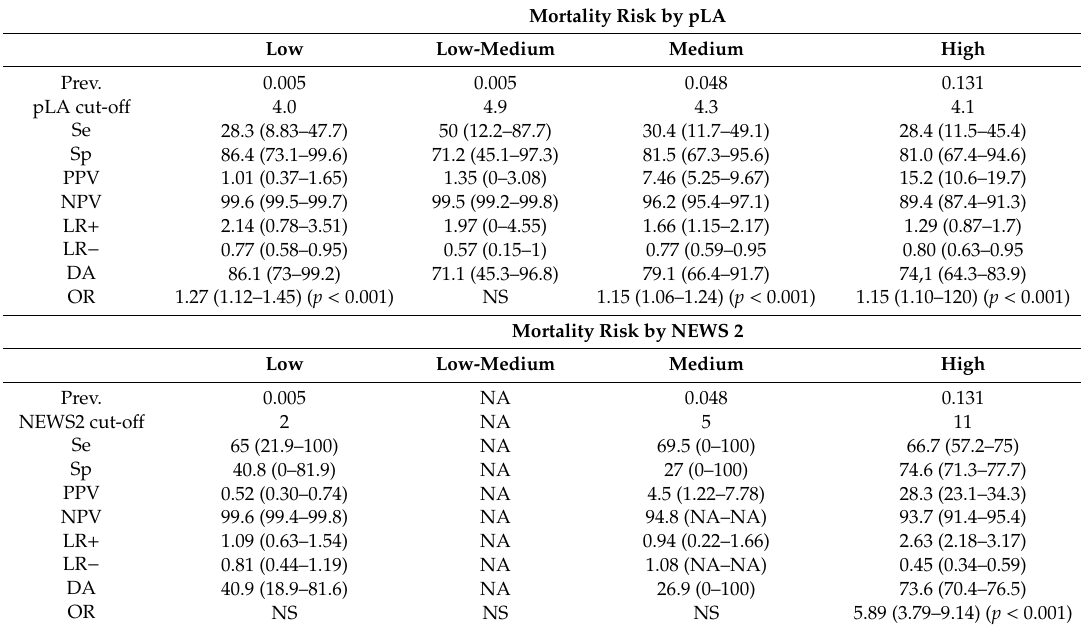
Table 5. Measures of the predictive model.